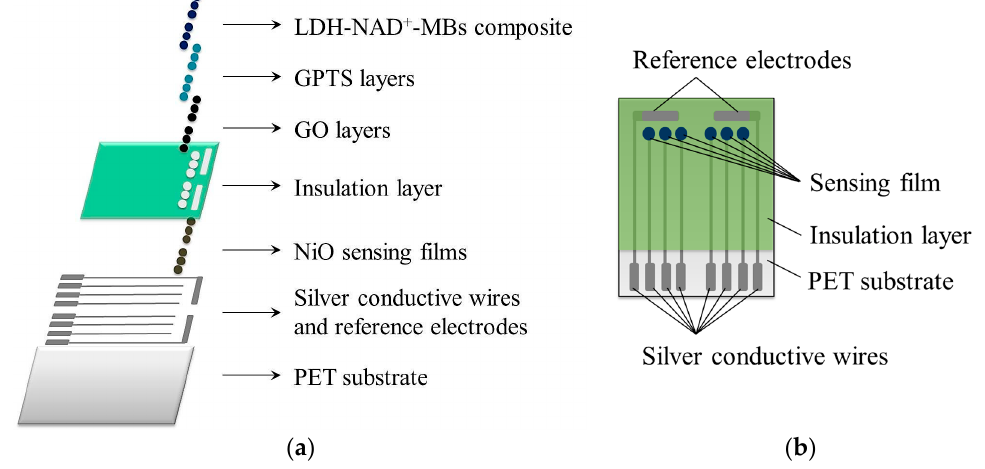
Figure 1. ( a ) The fabrication process and ( b ) the schematic diagram of flexible arrayed lactate biosensor.